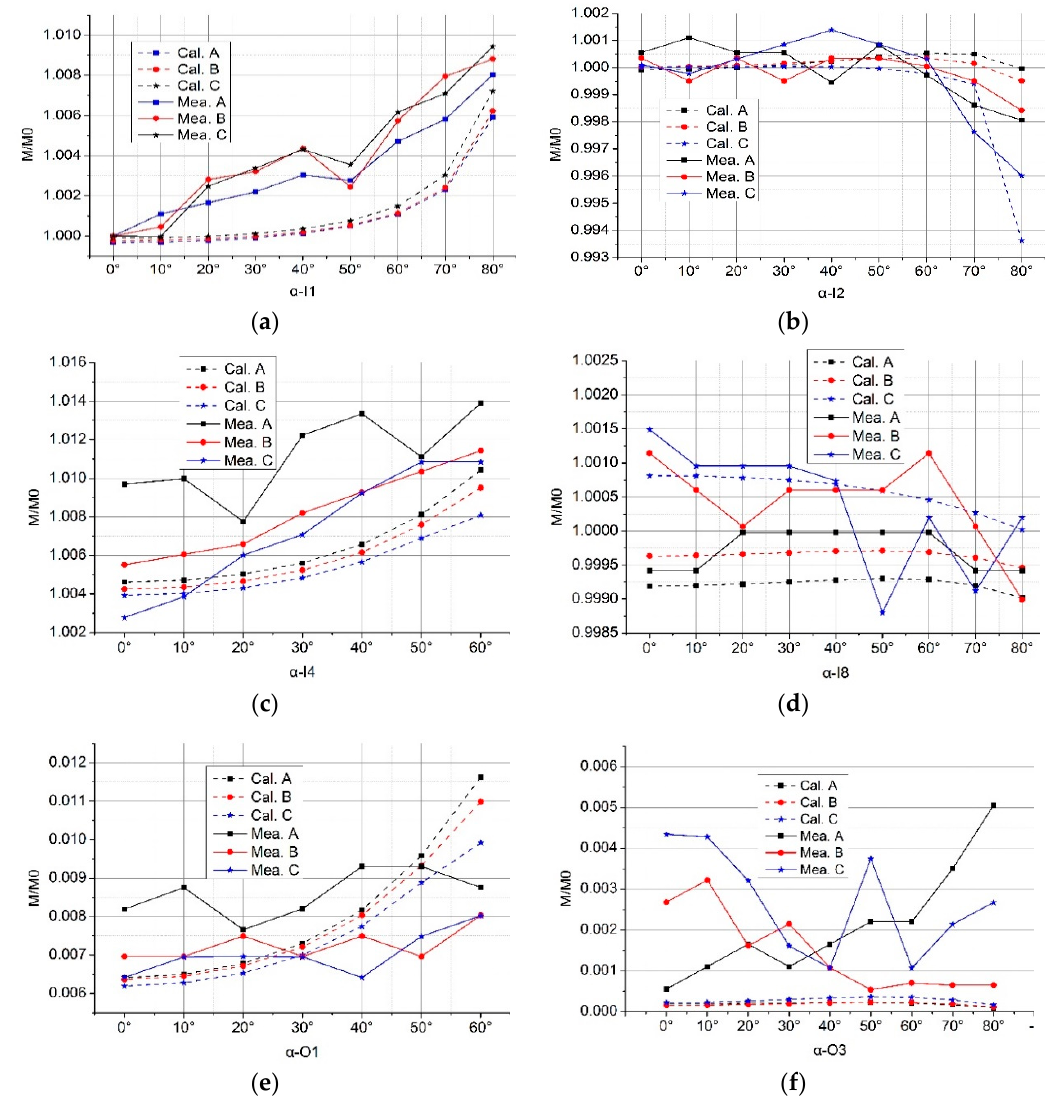
Figure 8. Normalized mutual inductance vs. tilted angle when the straight primary conductor does not go vertically through different positions of Coil A, Coil B, Coil C. ( a ) At inner hole I1; ( b ) at inner hole I2; ( c ) at inner hole I4; ( d ) at inner hole I8; ( e ) at outer hole O1; ( f ) at outer hole O3.